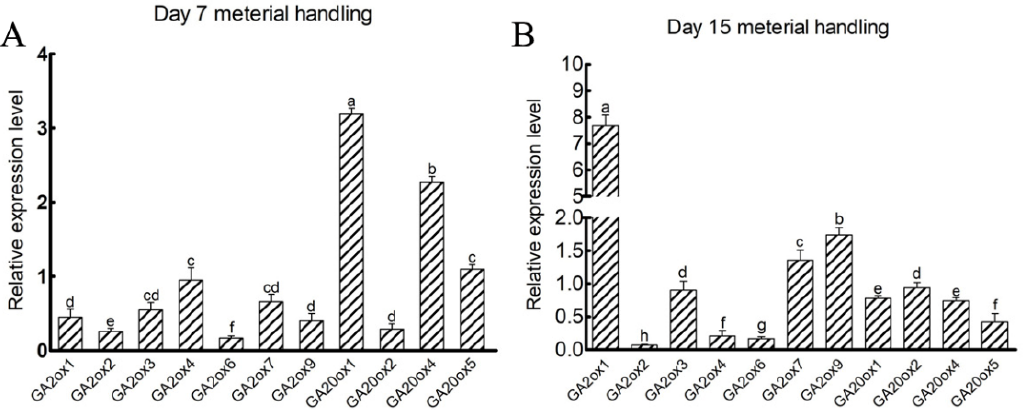
Figure 6. Relative expression levels determination of GA2ox and GA20ox genes in mesocotyls of Ltx05 at 1 and 10 cm sowing depths cultivated for 7 days ( A ) and 15 days ( B ) by qRT-PCR. The values are means ± SD of three replicates. Different letters indicate significant difference at p <